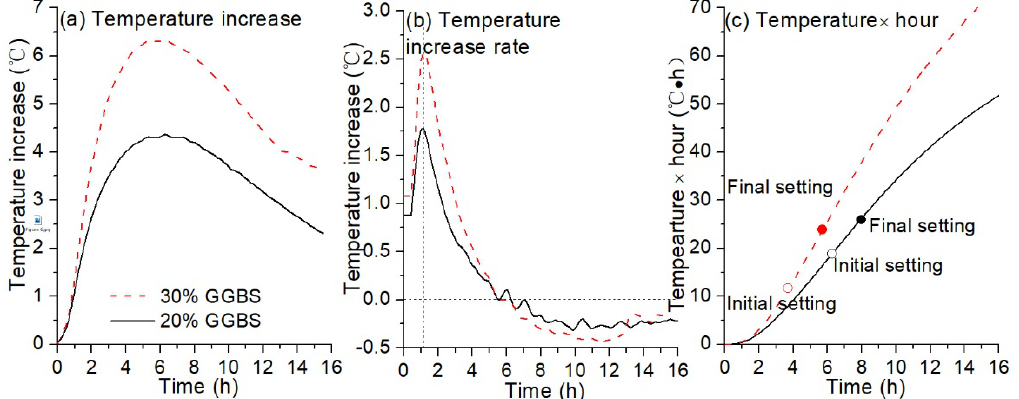
Figure 7. Temperature increase of alkali activated LFA-GGBS hybrid binder with different GGBS content (Na 2 O content 10%, n = 1.4, and w / s = 0.4): ( a ) temperature increase; ( b ) temperature increase rate; ( c ) temperature × hour.